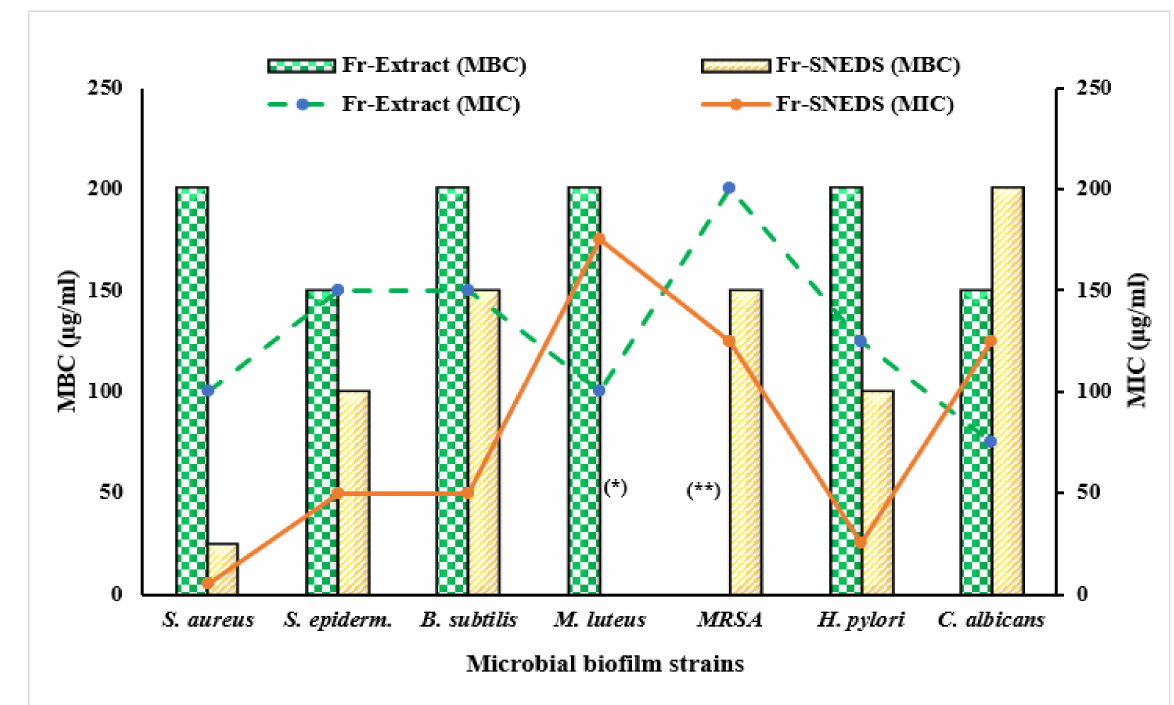
Figure 7. MICs and MBCs ( µ g mL − 1 ) of Fr-extract and Fr-SNEDS formulation against different microbial strains. (*) Fr- SNEDS MBC against M. luteus was not determined, (**) Fr-extract MBC against MRSA was >200.